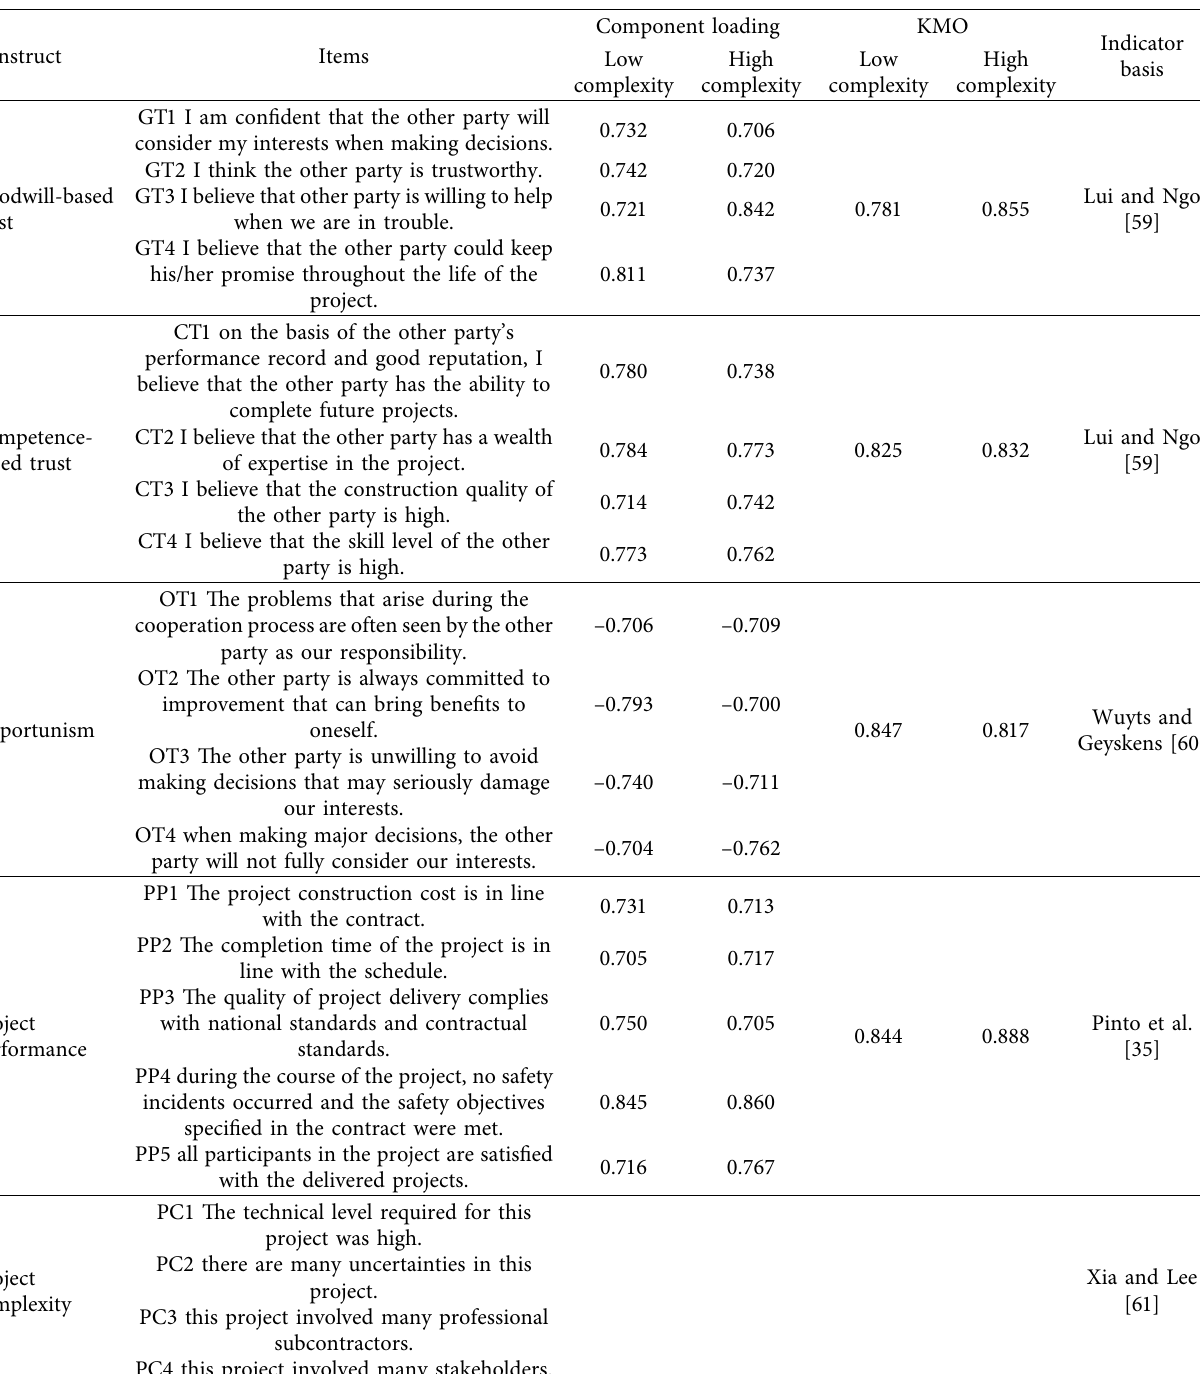
Table 2: Constructs and items.